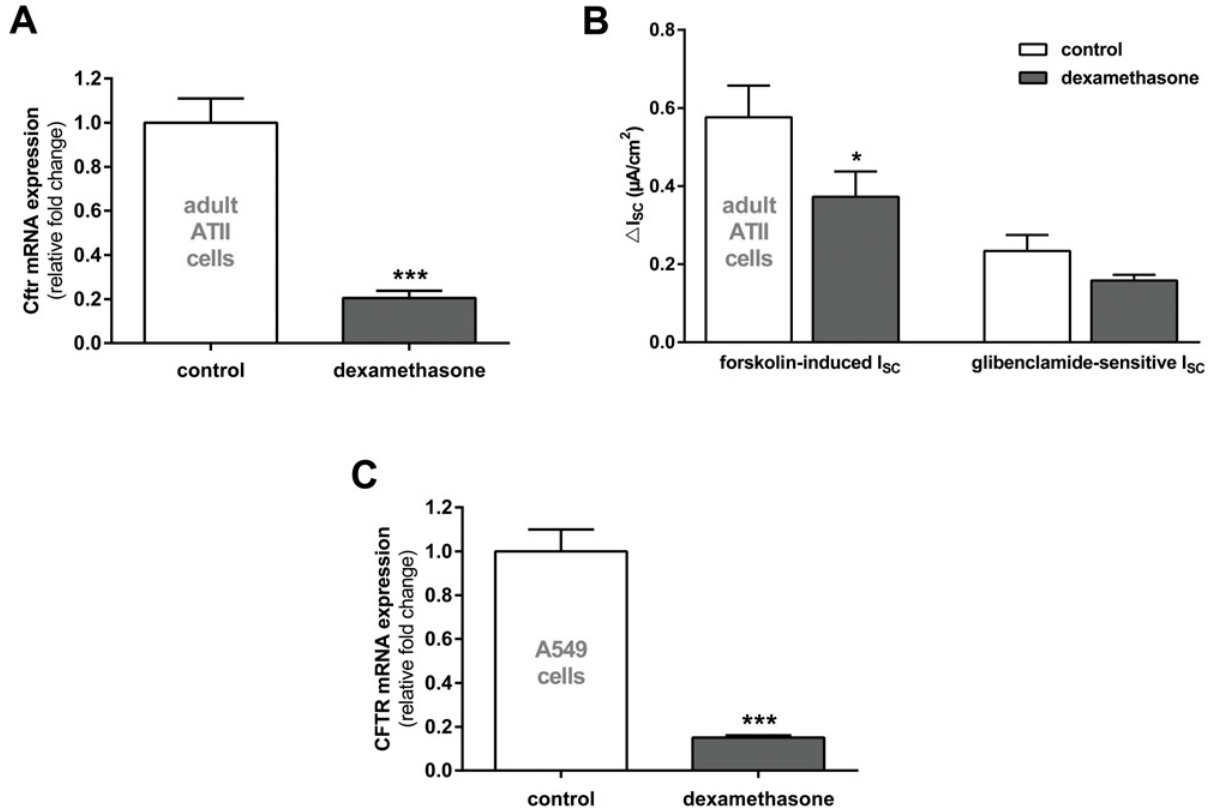
Fig 3. Dexamethasone reduces CFTR/Cftr mRNA expression and channel activity in adult alveolar cells. A/B: primary adult ATII cells. A: Graph represents the mean + SEM for normalized Cftr mRNA expression in response to 100 nM dexamethasone for 24 h acquired by RT-qPCR (n = 6, *** p < 0.001 by T-test compared to control monolayers without dexamethasone addition). B: Graph represents the mean + SEM of I SC in response to 100 nM dexamethasone for 24 h measured in Ussing chambers. Forskolin-induced I SC (n = 29 – 31, * p < 0.05 by T-test compared to control monolayers